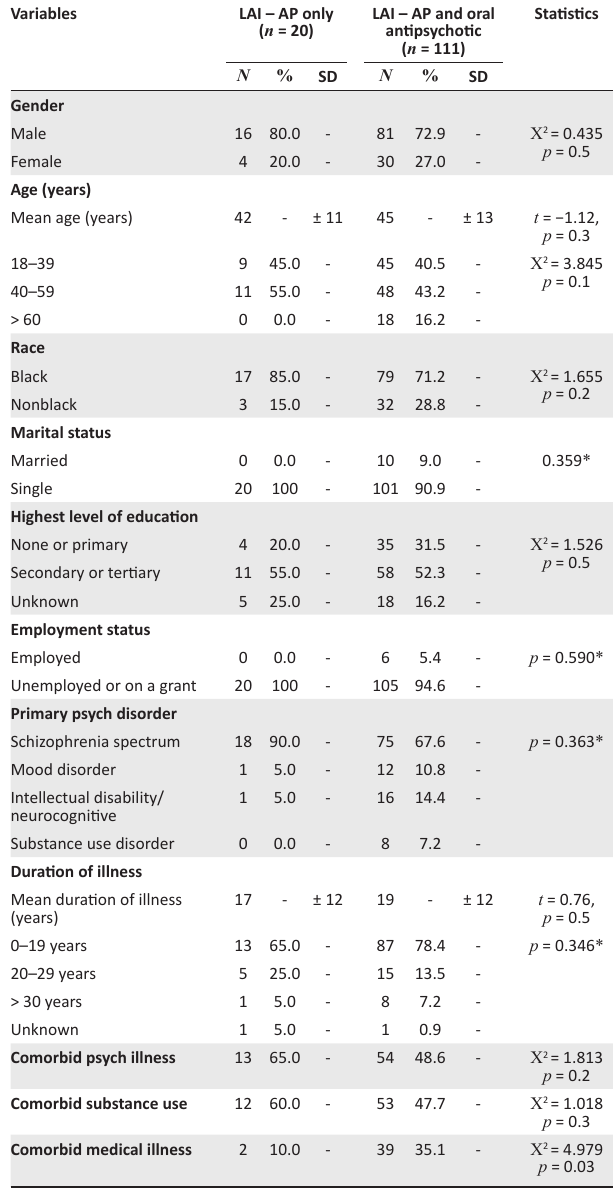
TABLE 4: Frequency distribution of the sociodemographic and clinical characteristics of patients on long-acting injectable antipsychotics (LAI – APs) only, compared with those on LAI – AP combined with oral